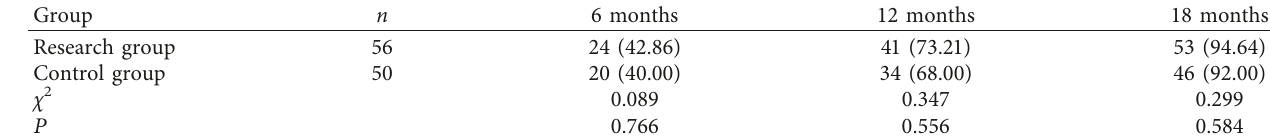
Table 4: Comparison of the bone graft fusion rate between the two groups (n (%)).